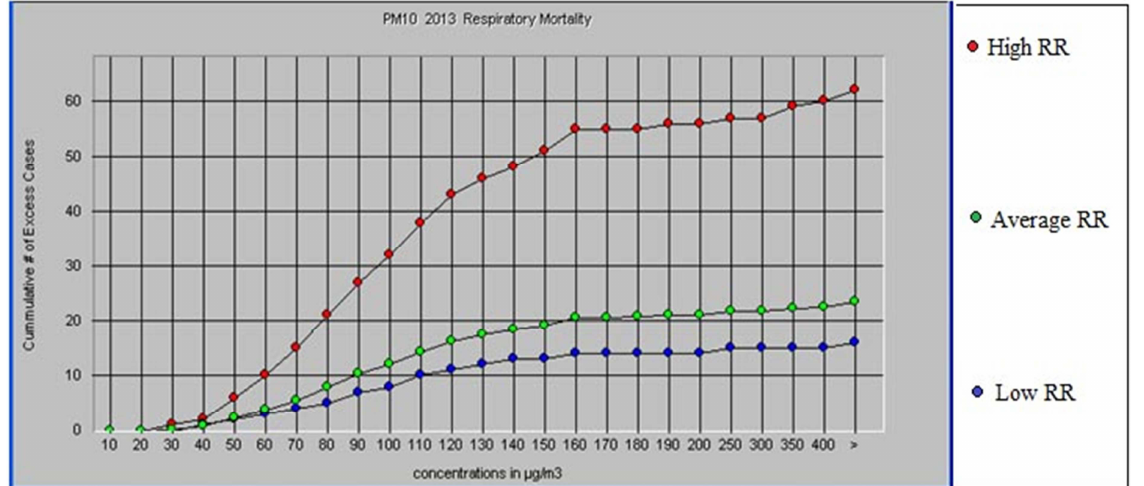
Figure 7. Estimated cumulative number of respiratory mortality cases attributable to particulate matter with aerodynamic diameters <10 µm comparing concentration intervals (Sanandaj, Iran, 2013) RR: Relative